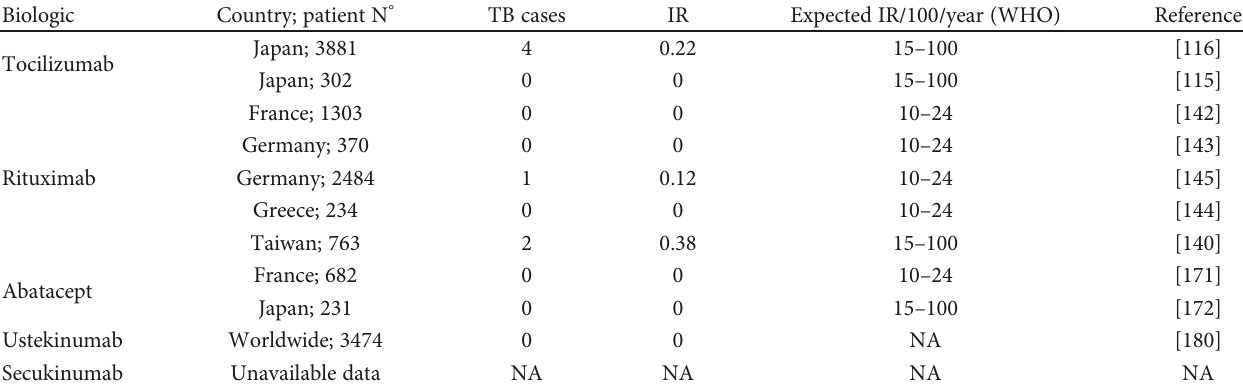
Table 2: Non-anti-TNF-targeted biologics: reported TB cases from national registries and postmarketing surveillance.